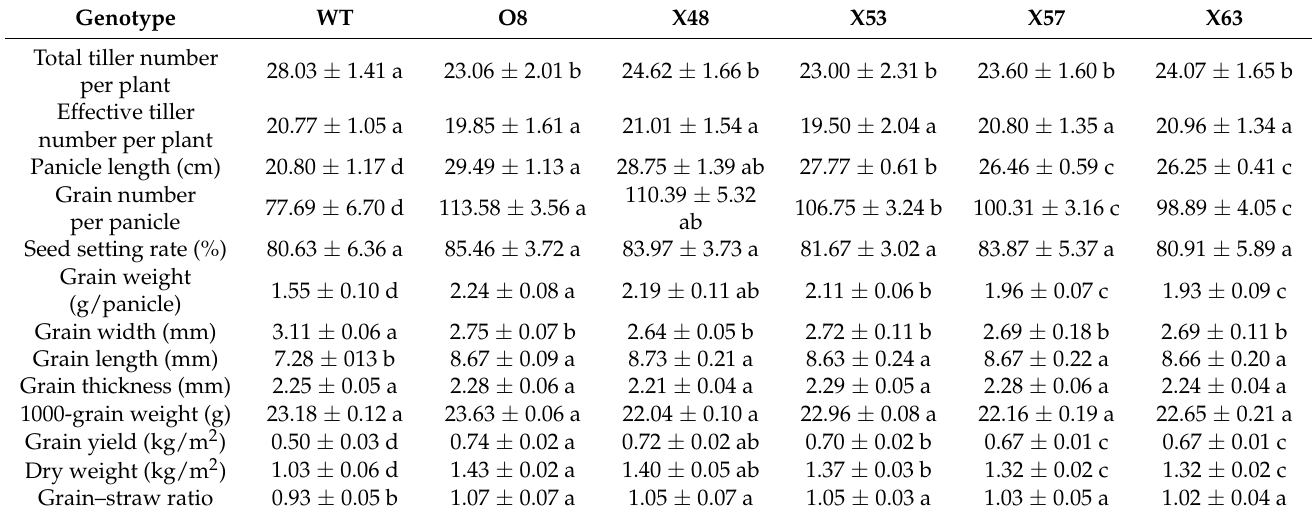
Table 1. Agronomic traits of WT, O8, and EMS